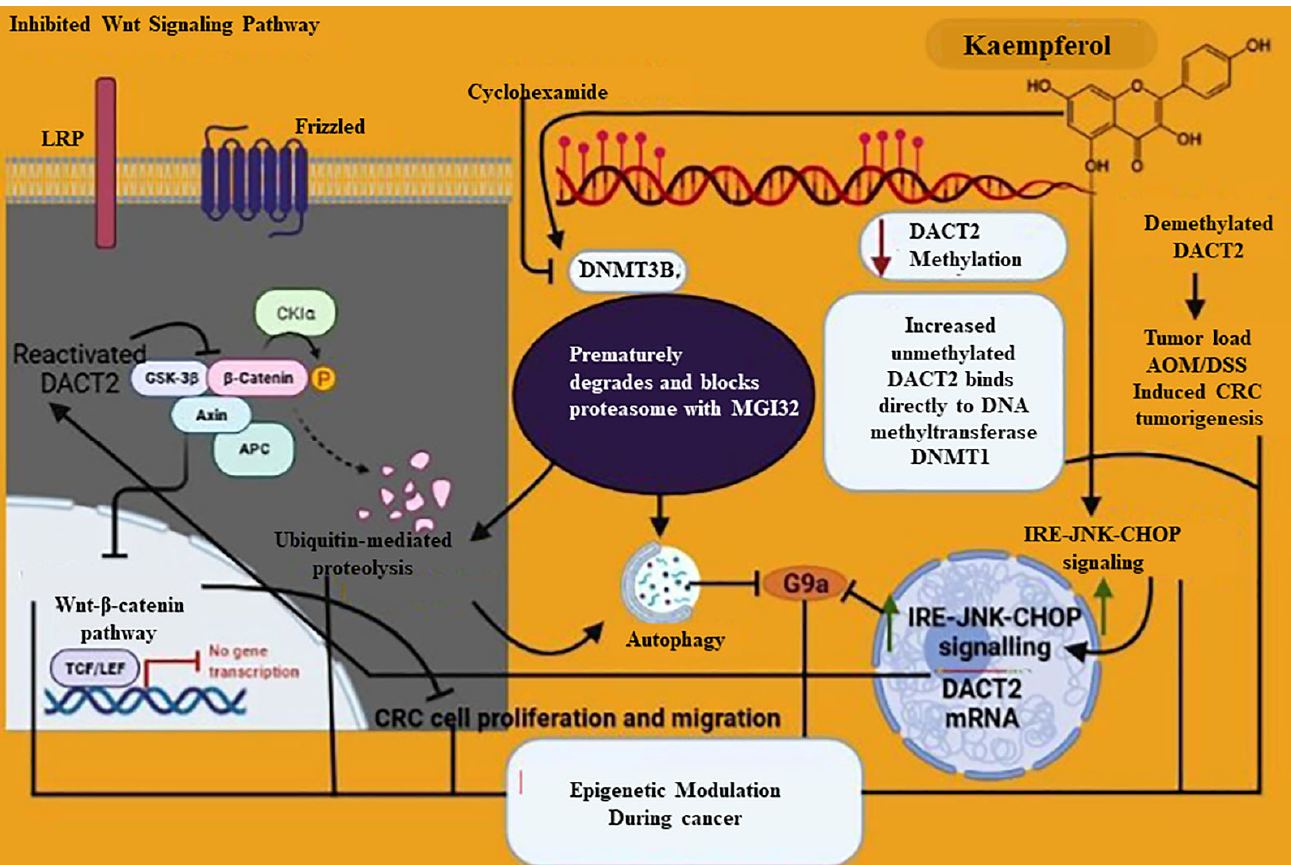
Figure 1. Molecular mechanism represents the role of kaempferol in epigenetic modulation during cancer and how it protects from cancer. Kaempferol protecting against cancer via a different mechanism such as inhibition of DNMT3B which prematurely degrades and blocks proteasome with MGI32 further causes autophagy via G9a inhibition and ubiquitin ‐ mediated proteolysis; on the other hand, reactivated DACT2 inhibits Wnt ‐β‐ catenin signaling pathway and leads to impairment of the CRC cell proliferation and migration further causes epigenetic modulation and protects against cancer; increased localization of the IRE ‐ JNK CHOP from cytosolic to the nucleus further inhibits G9a; decreased DACT2 methylation; increased unmethylated DACT2 binds directly to DNA methyltransferase DNMT1 and is involved in epigenetic modulation during cancer.